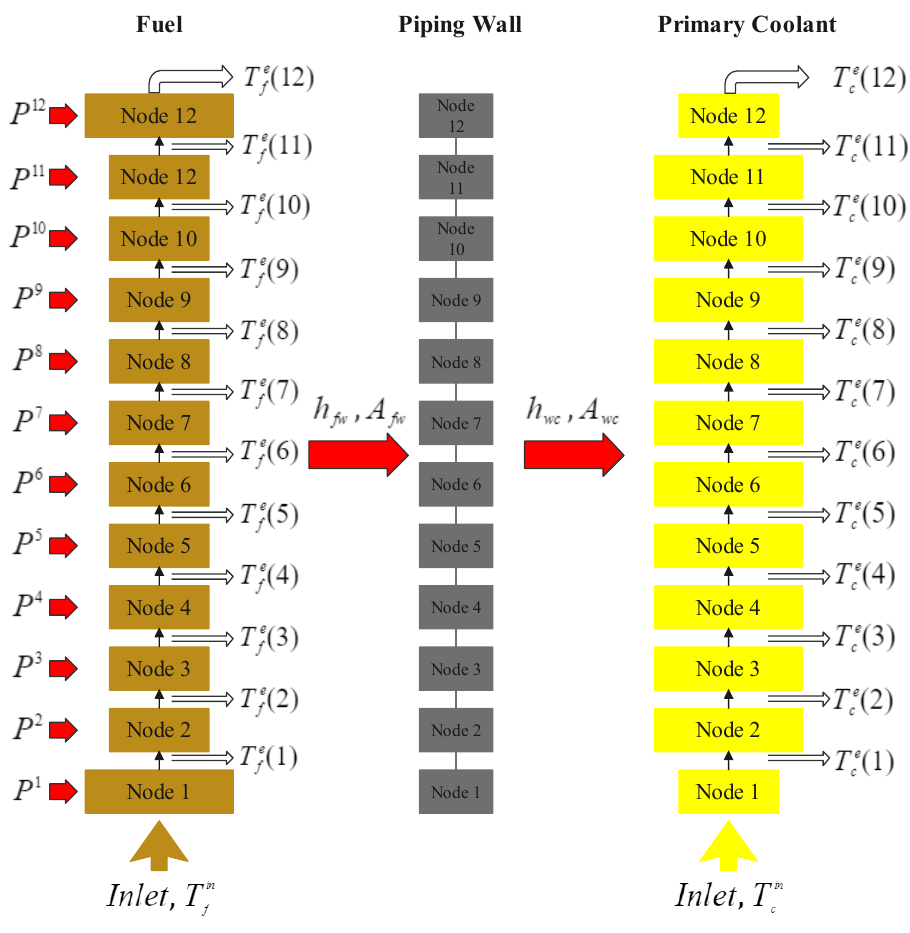
Figure 5. Schematic of nodalization and energy